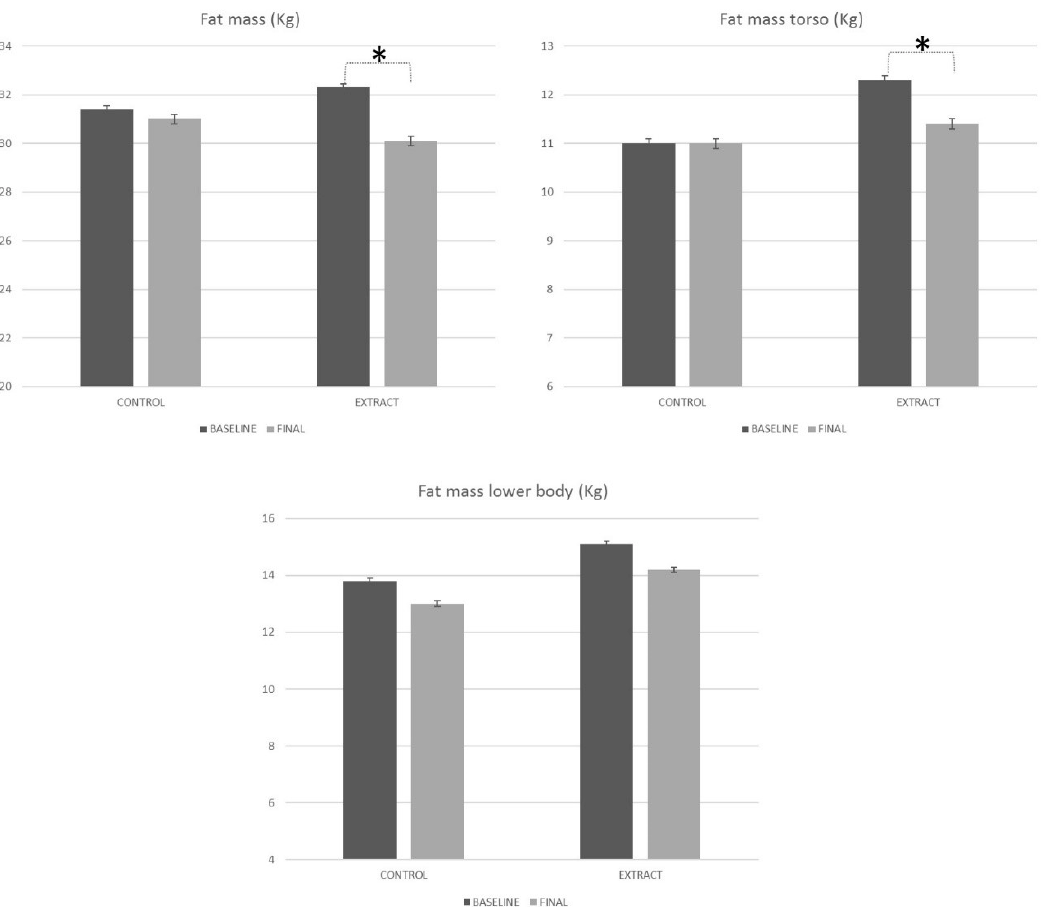
Figure 4. Body composition evolution along the study, measured by densitometry. * Means statistically significant differences.